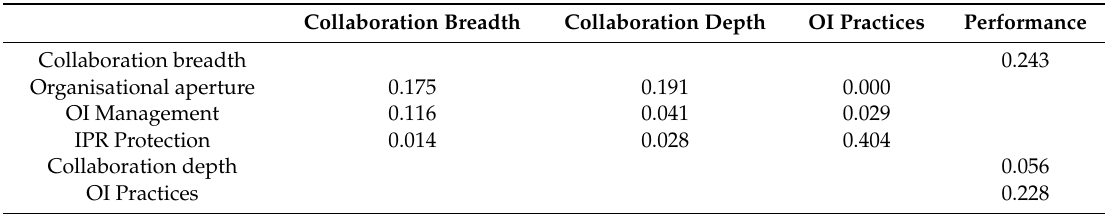
Table 15. Coe ffi cient of determination e ff ect size ( f 2